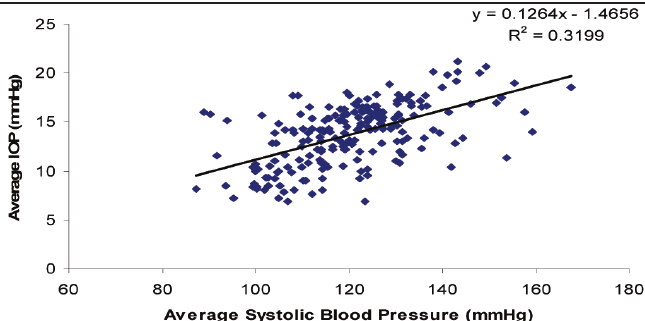
Figure 3: Showing the relationship between average IOP and average systolic BP.